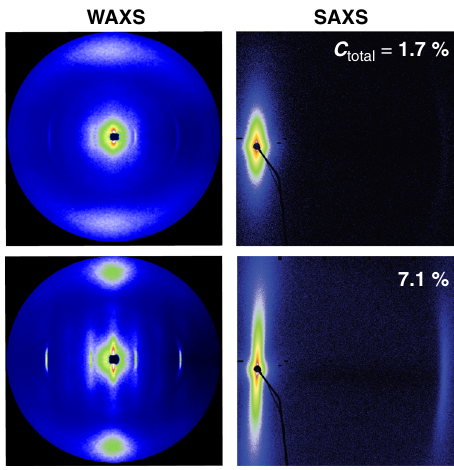
Fig. 3 Nanostructure of PBDT + GO nanocomposite fi lm. WAXS and SAXS scattering results measured at α = 0 ° ( fi lm edge-on scattering) for PBDT + GO nanocomposite fi lms cast from C total = 1.7 wt.% ( I phase)